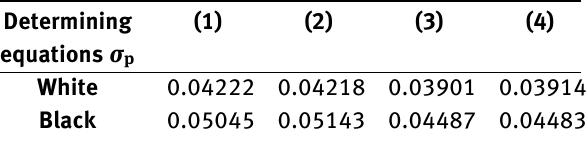
Table 3: Values of aim function Φ σ